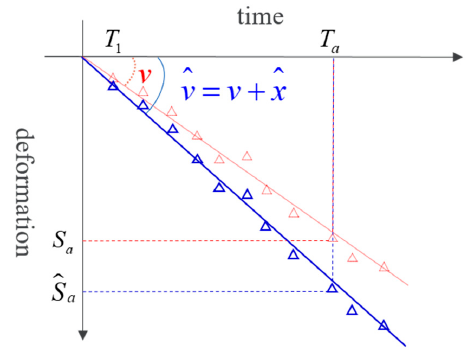
Figure 3. Deformation sequence correction diagram.